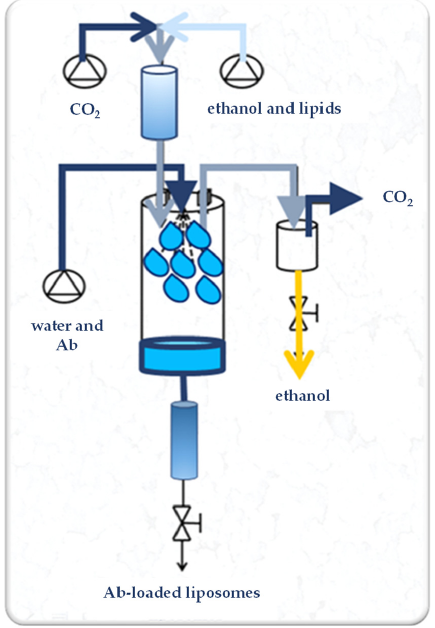
Figure 1. Experimental set ‐ up of the SuperLip process. Ab: antibody. Operative parameters adopted for this study were selected from a previous operative parameter optimization study [41]. In detail, the pressure was equal to 100 bar, the temperature was set at 40 °C, the lipid solution flow rate was 3.5 mL/min, the gas ‐ to ‐ liquid ratio (G/L) was 2.4 ( w / w ), the water solution flow rate (WFR) was in the range from 1 to 10 mL/min, and the Ab loading was from 0 to 12% ( w / w ) in respect to lipid content (Table 1). Table 1. Operative parameters used for the production of loaded liposomes by the SuperLip apparatus. G/L: gas ‐ to ‐ liquid ratio, WFR: water solution flow rate, Ab/Lipids: antibody ‐ to ‐ lipid mass ratio. Operative Parameter